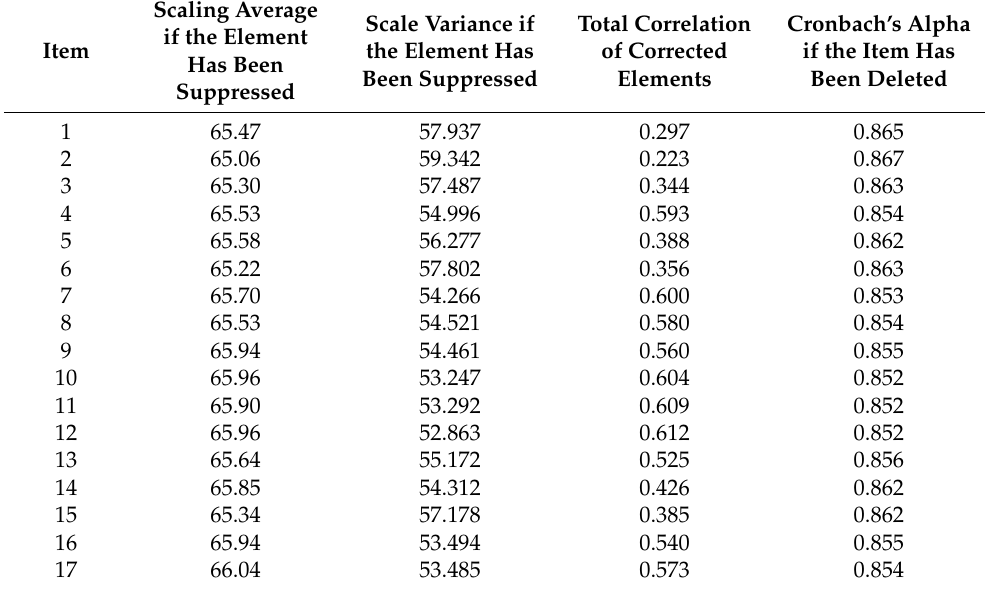
Table 11. Statistics associated with Cronbach’s